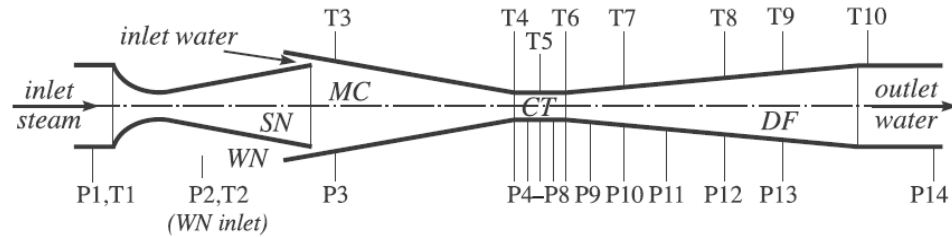
Figure 26. Flow channel and points of study of steam jet ejector [89].